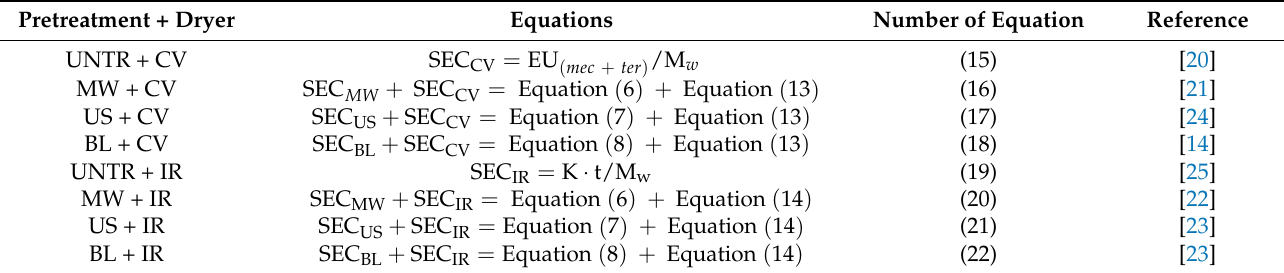
Table 1. Special energy consumption equations in hot and infrared air dryers with different pretreatments. Pretreatment +